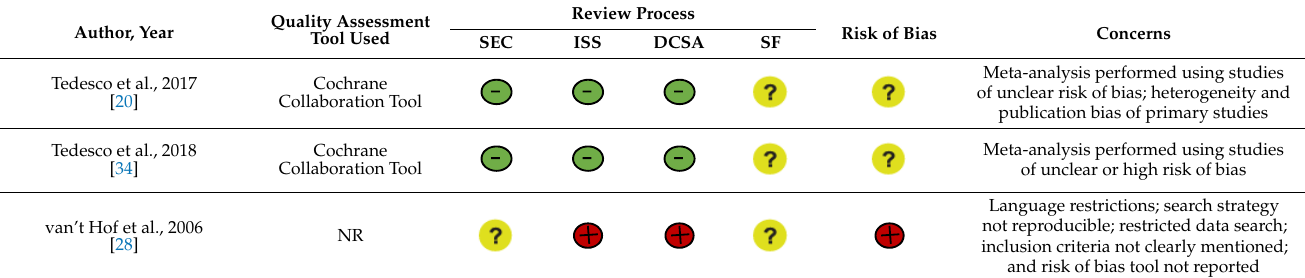
Table 2. Quality assessment of included reviews using the ROBIS tool.